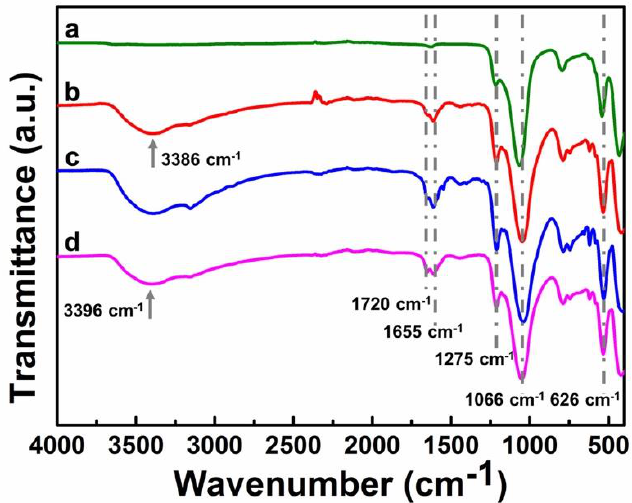
Figure 2. FT-IR spectra of zeolite ZSM-5 and its immobilized catalysts: ( a ) ZSM-5; ( b ) ZSM-5-HO-[PECH-MIM]Cl/[ZnBr 2 ]; ( c ) ZSM-5-HOOC-[PECH-MIM]Cl/[ZnBr 2 ]; and ( d ) ZSM-5-H 2 N-[PECH-MIM]Cl/[ZnBr 2 ].